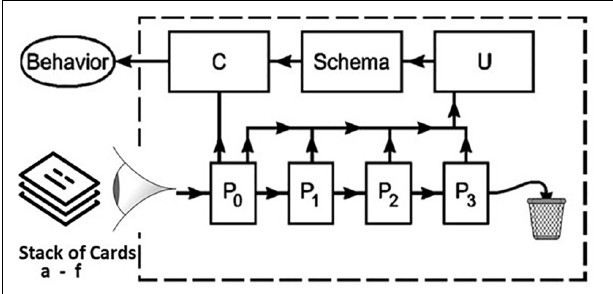
FIGURE 1 | Schema for the model information gathering and utilization system (IGUS). At every proper time interval, the robot captures an image of its external environment. In this case, the robot experiences a stack of cards labeled a , b , c, d, e, f , etc. whose top member changes from time to time. The IGUS robot chooses how to route and utilize its information. Figure modified from Hartle